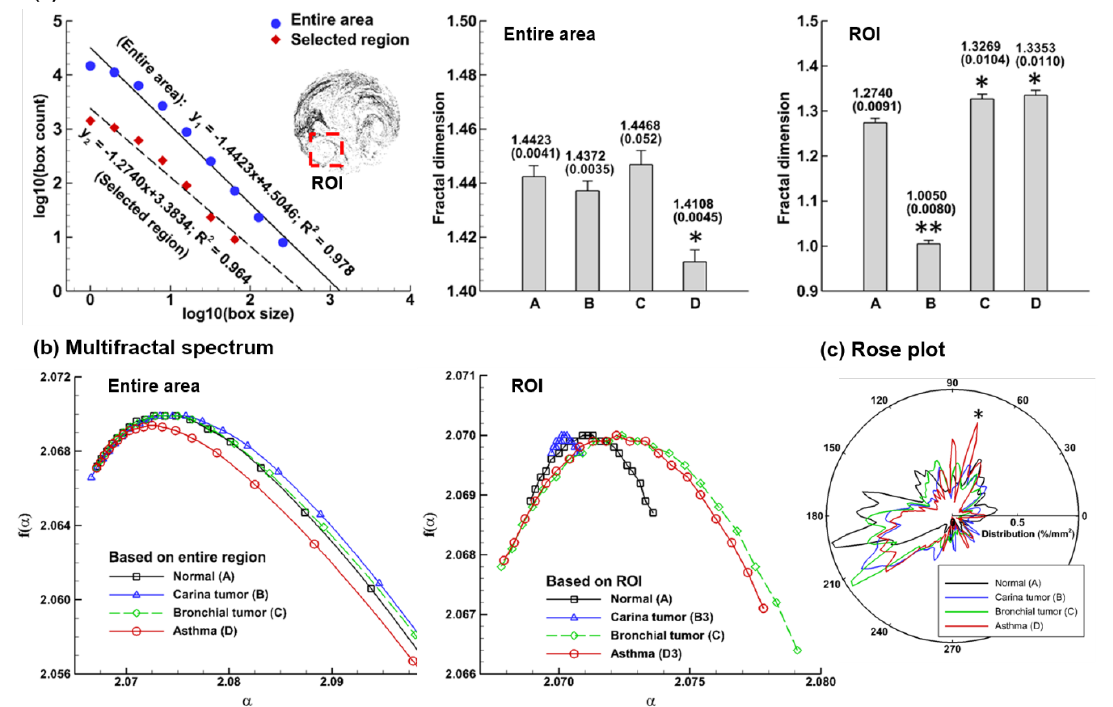
Figure 6. Fractal and multifractal analyses of exhaled aerosols from the normal and three diseased airway models: ( a ) box-counting method to calculate fractal dimension, FD ( left ), and FDs of the whole image ( middle ) and ROI ( right ); ( b ) multifractal spectra for the whole image ( left ) and ROI ( right ). The spatial distribution of aerosols was also visualized as a rose plot in ( c ). *: p ≤ 0.05; **: p ≤ 0.01.